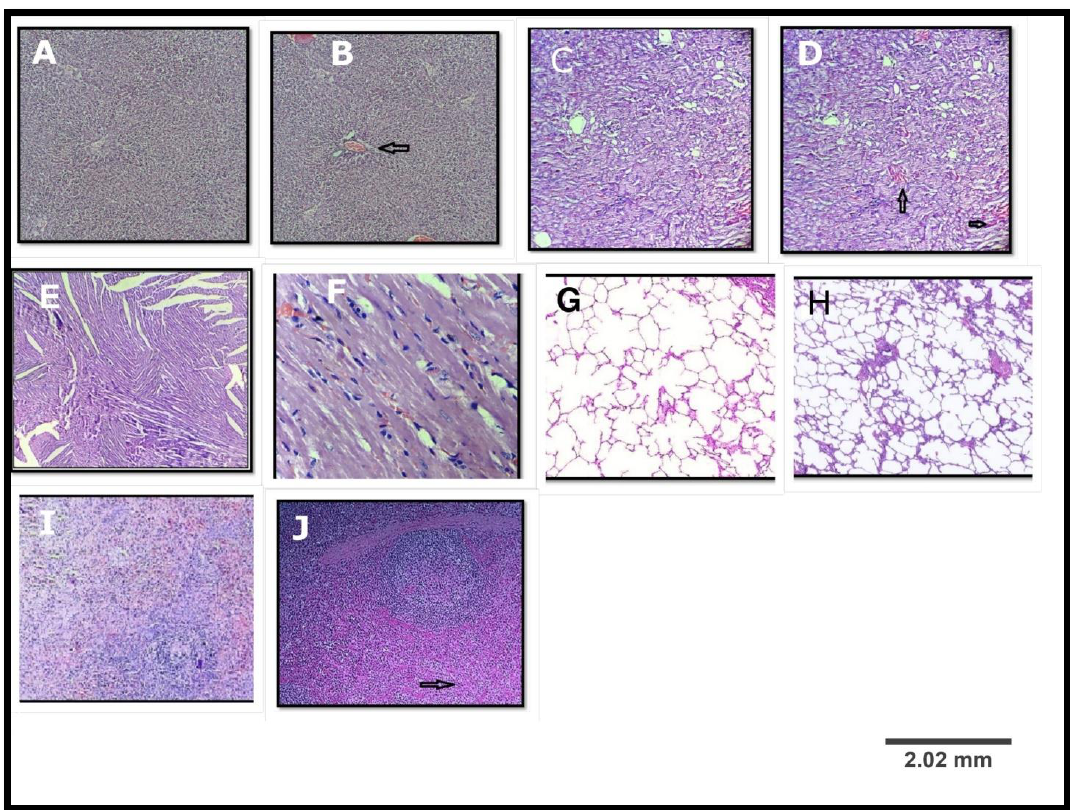
Figure 1. Histopathological examination of various organs of the rat in acute oral toxicity study; ( A , C , E , G , I ) are liver, kidney, heart, lung, and spleen of the control group; ( B , D , F , H , J ) are liver, kidney, heart, lung, and spleen of the treated group. ( B ) A hydrophobic degeneration along with mild congestion in portal vein (arrow); ( D ) mild congestion in intertubular blood vessels(arrow); ( F ) normal myocardium; ( H ) normal lung; and ( J ) mild congestion in red pulp (arrow). (Haematoxylin & Eosin, (H&E) × 100).